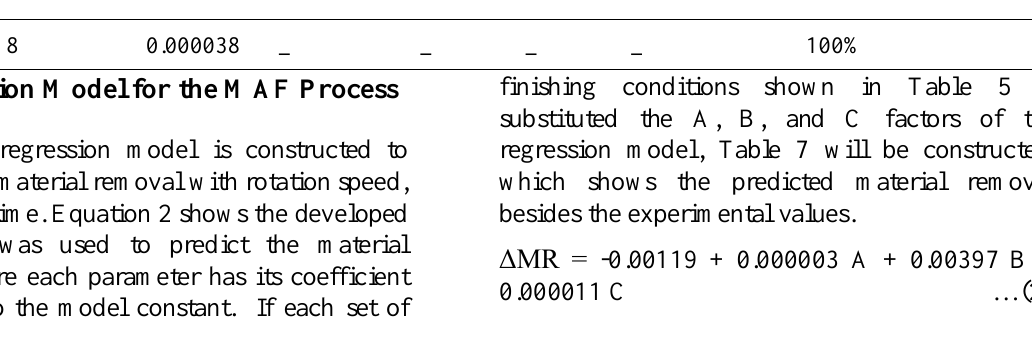
Predicted and Experimental ΔMR with average % error. Run No.